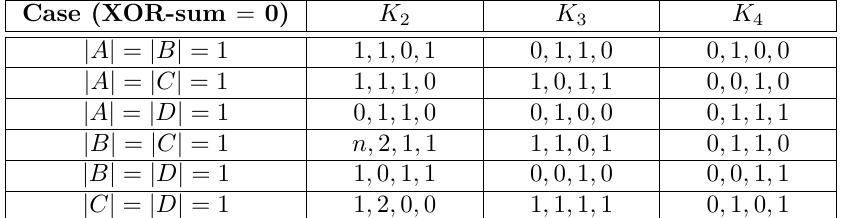
Table 4: Number of active bytes in every column of K 2 , K 3 , K 4 when we have a two active bytes in A/B or A/C or A/D or B/C or B/D or C/D with XOR-sum = 0, where n is either 0 or